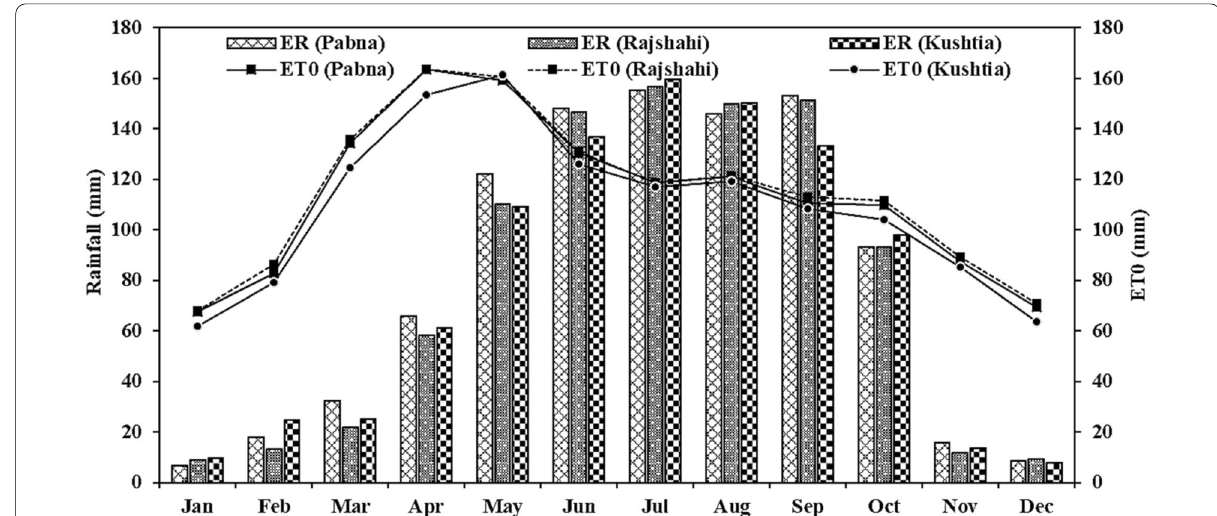
Fig. 2 Monthly distribution of normalize (1981–2017) effective rainfall (ER) and potential evapotranspiration (ET 0 ) in Kushtia, Pabna and